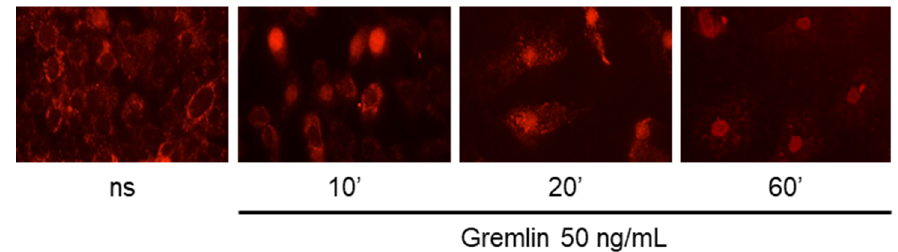
Figure 3. In situ DNA/CREB interaction in CAM sections. ( A ) Control and gremlin-stimulated CAM sections (5 μ m) were permeabilized and incubated with Cy5-labeled palindromic CREB binding oligo-probes. Nuclei were counterstained with DAPI (magnification 20×). ( B ) Gremlin-stimulated CAM sections (5 μ m) were permeabilized and incubated with Cy5- scrambled oligo-probes. ( C ) Magnification (40×) of gremlin-stimulated CAM sections (5 μ m).